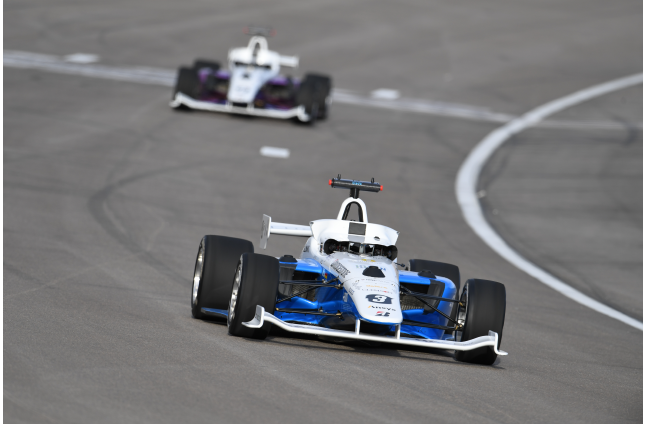
Figure 1. The Dallara AV-21 race cars of the TUM Autonomous Motorsports and TII EuroRacing team during the AC@CES on the